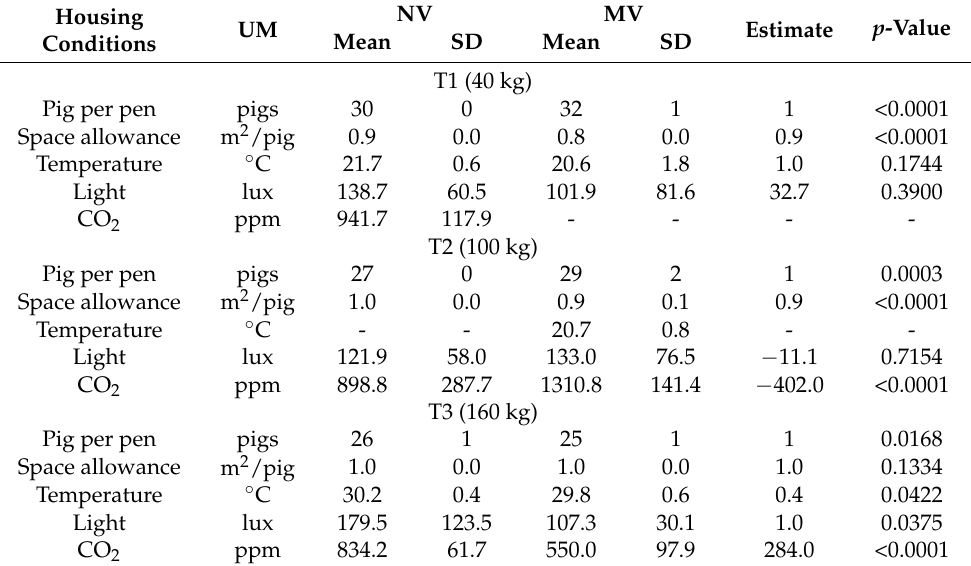
Table 6. Main data on the housing conditions obtained from the measurements realized during the monitoring